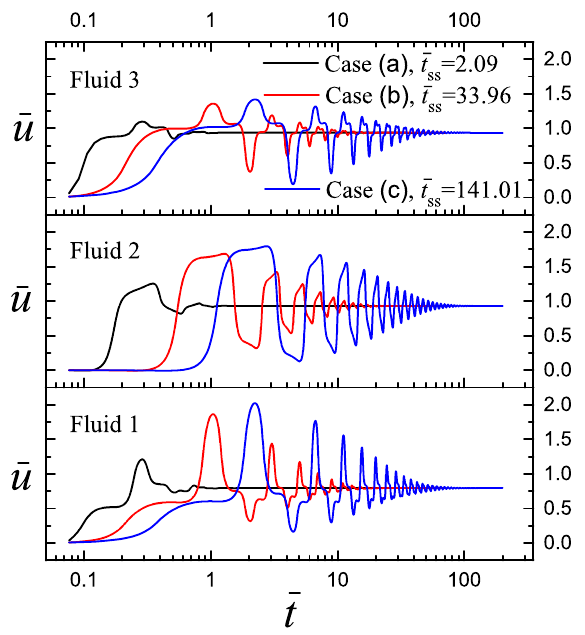
Figure 7. Velocity tracking of an electro-osmotic flow, cases taken from Figure 4. Case ( a ) ¯ λ n = 0.1, Case ( b ) ¯ λ n = 2.0, and Case ( c ) ¯ λ n = 10 at the middle of each fluid layer.